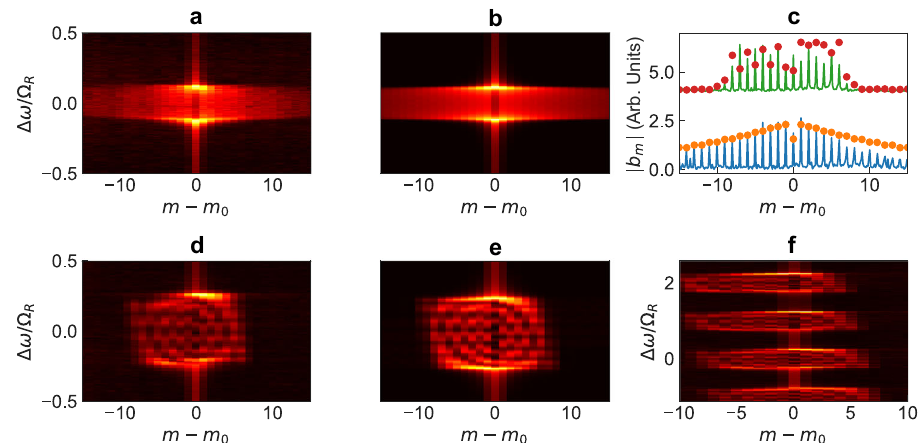
Fig. 3 Amplitude distribution in frequency lattice space. a , b Without and ( d – f ) with an auxiliary ring, corresponding to in fi nite and fi nite lattices respectively. a , d , f are experimentally measured heterodyne spectra. b , e are obtained from simulations based on a Floquet scattering matrix analysis. c Blue (in fi nite) and green ( fi nite) curves represent line cuts through the raw heterodyne data at Δ ω ≈ 0. Dots represent line cuts through respective simulated spectra in panels ( b , e ) respectively. The in fi nite lattice data without an auxiliary ring is vertically offset by 4 units. f The heterodyne spectra similar to ( d ) but over a much larger range of input laser detuning Δ ω > Ω R , thus exciting various lattice sites between the two boundaries. The breakdown of discrete modal translational symmetry is evident, as the response changes depending on which frequency site is excited. Due to re fl ection from the boundaries, fringes are visible in ( d – f ). Here the frequency mode axis ( m − m 0 ) is measured with respect to the input laser frequency. Arb. Units arbitrary units.